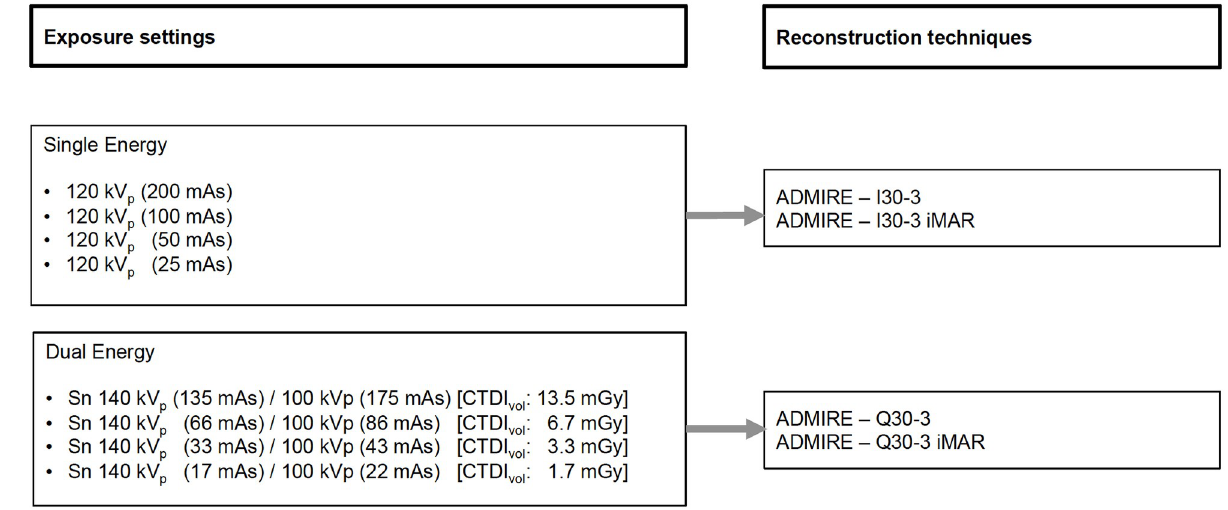
Fig 1. CT acquisition and reconstruction settings.